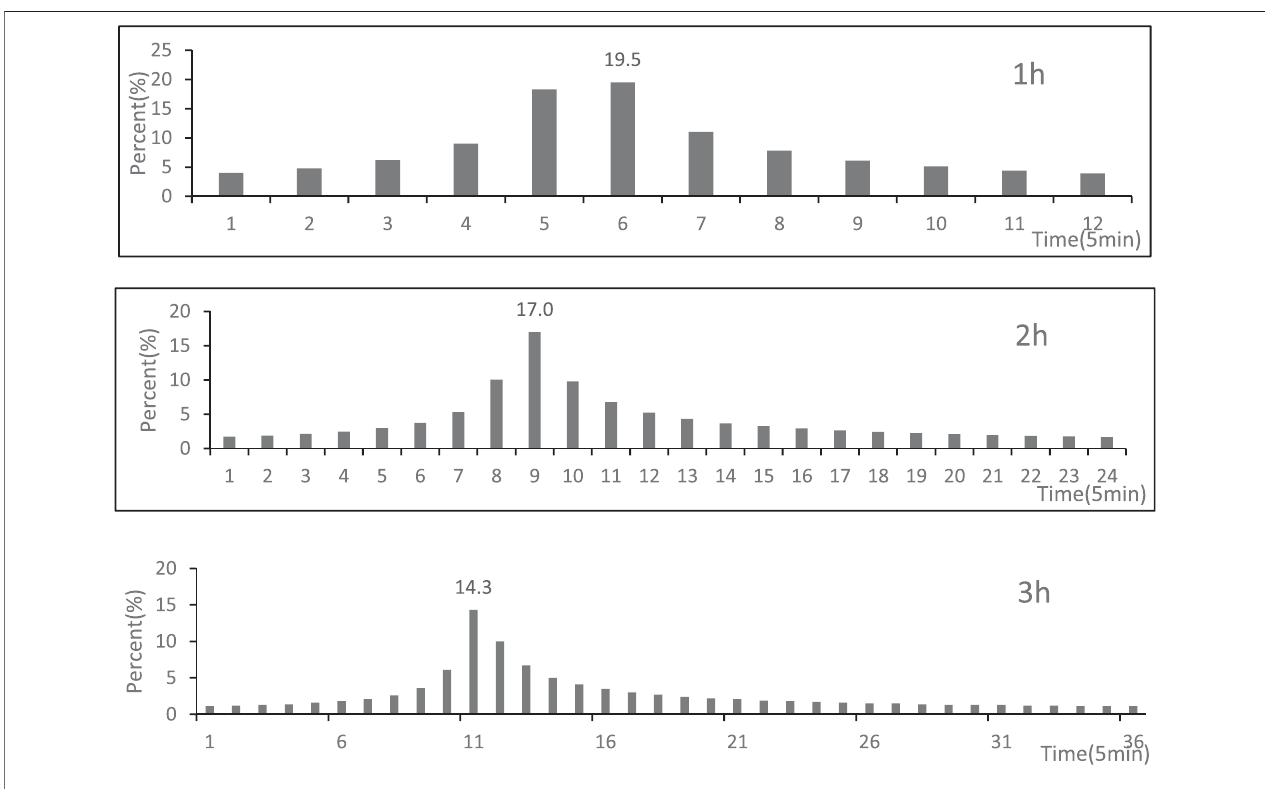
FIGURE 1 | The designed rainstorm hyetographs for 1, 2, and 3-h durations obtained with the Chicago rainstorm method.